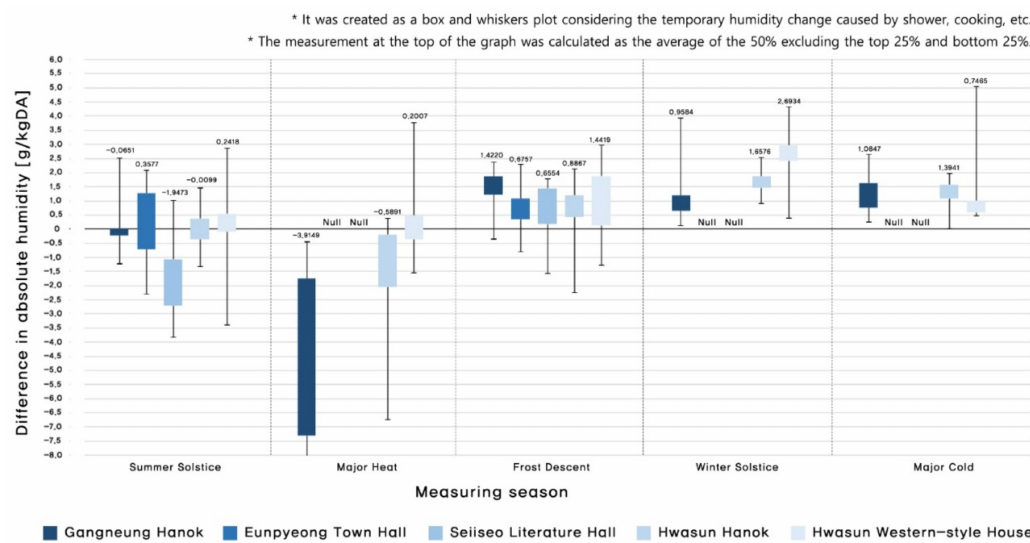
Figure 2. Difference in absolute humidity indoors and outdoors by